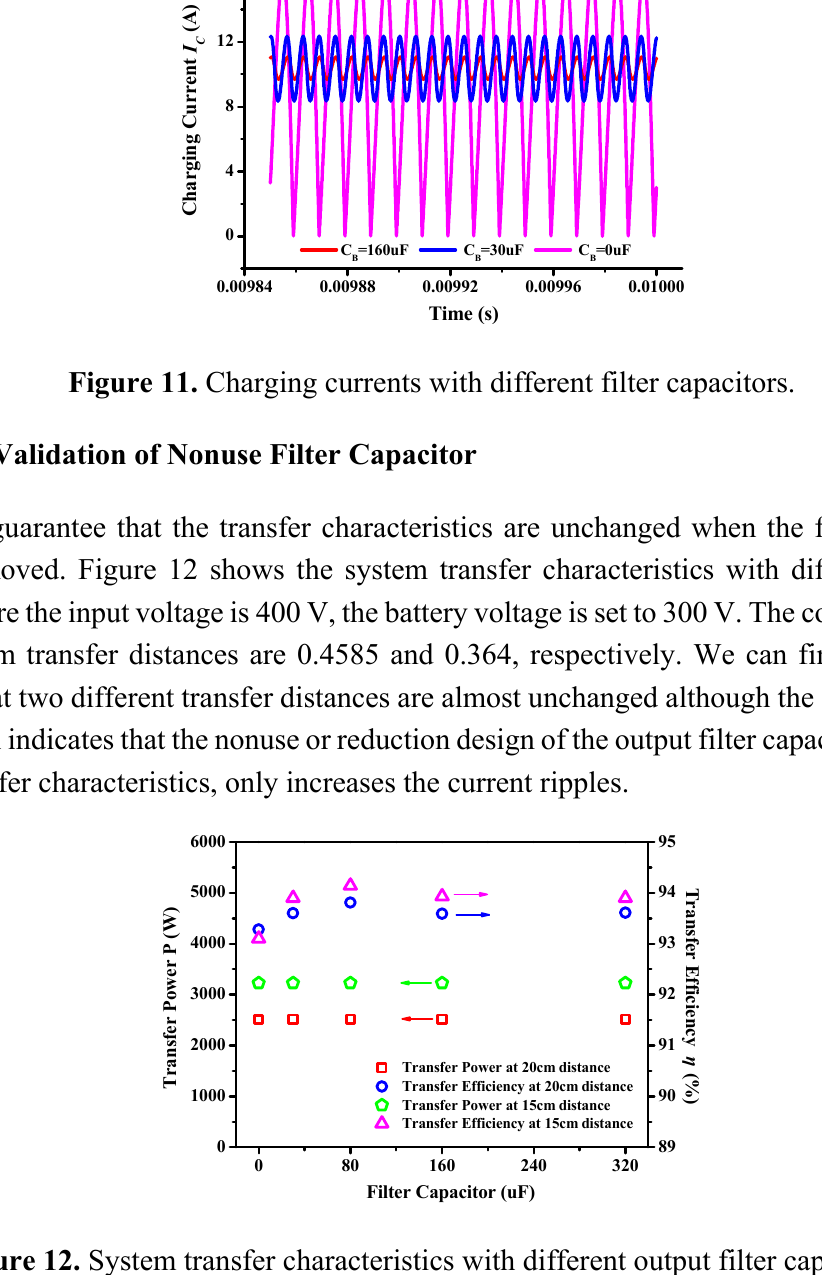
Figure 12. System transfer characteristics with different output filter